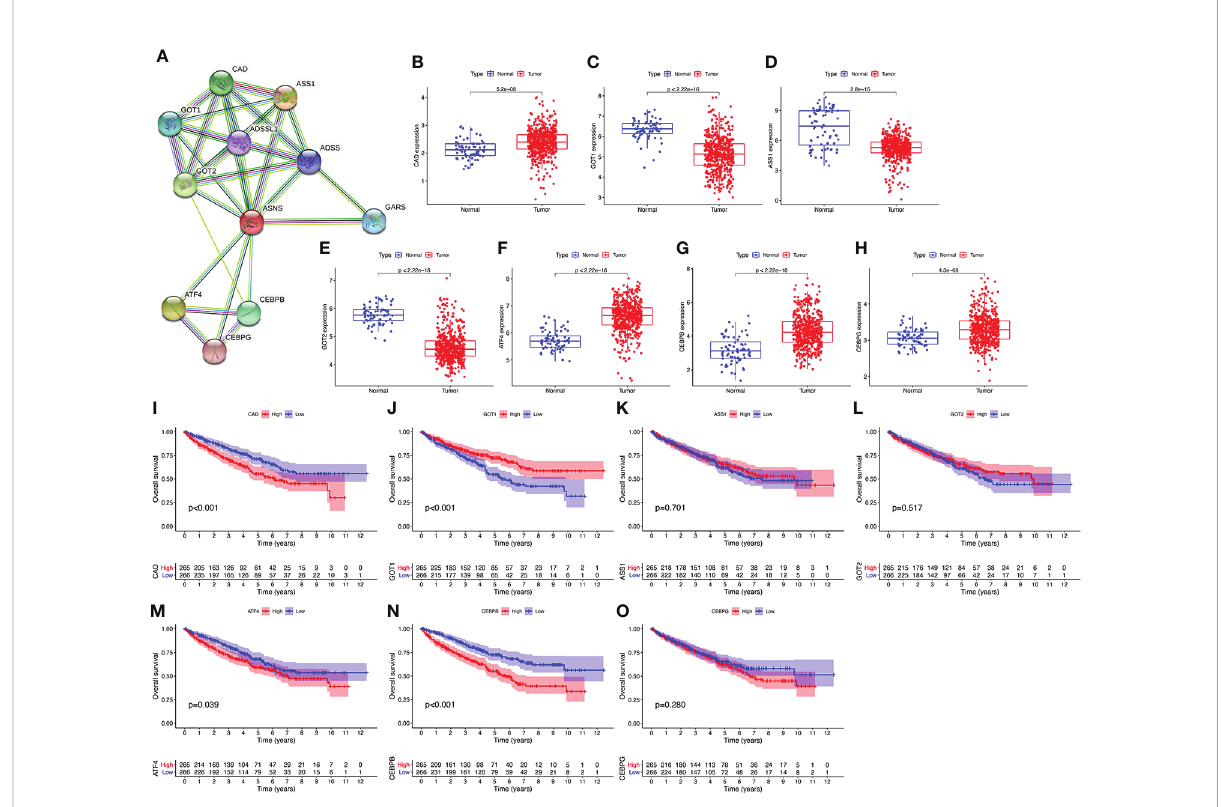
FIGURE 7 Protein – protein interaction (PPI) network analysis of ASNS. (A) The top 10 hub genes of the PPI network. (B – O) The expression pattern and prognostic values of these hub genes in ccRCC (the three missing genes were not found in the TCGA-KIRC